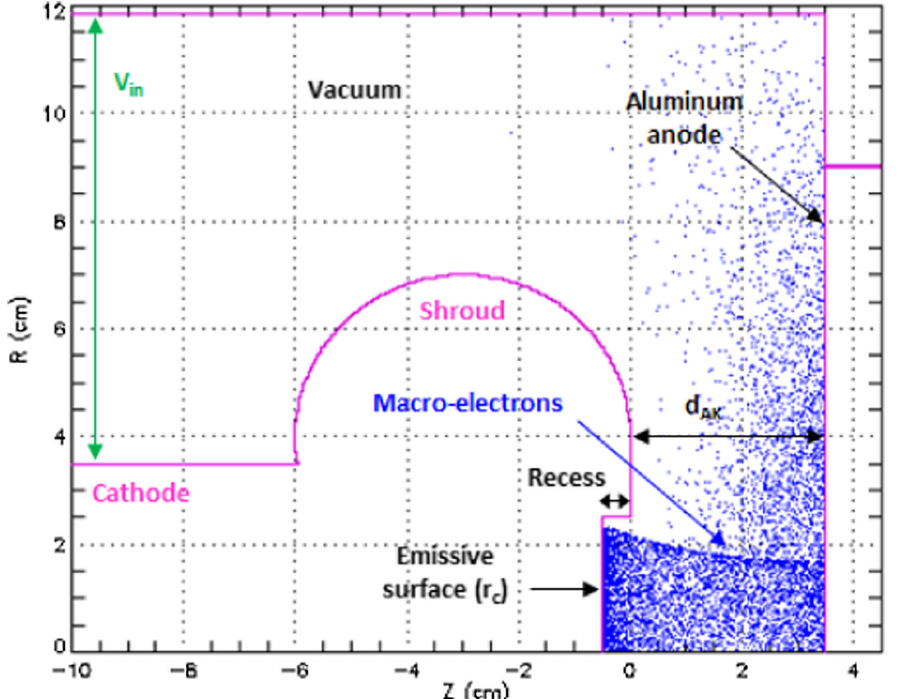
FIG. 3. Mi2 diode geometry used in the simulation with a 2.5 cm cathode radius, an anode-cathode gap of 3.5 cm, and a recess of 5 mm.